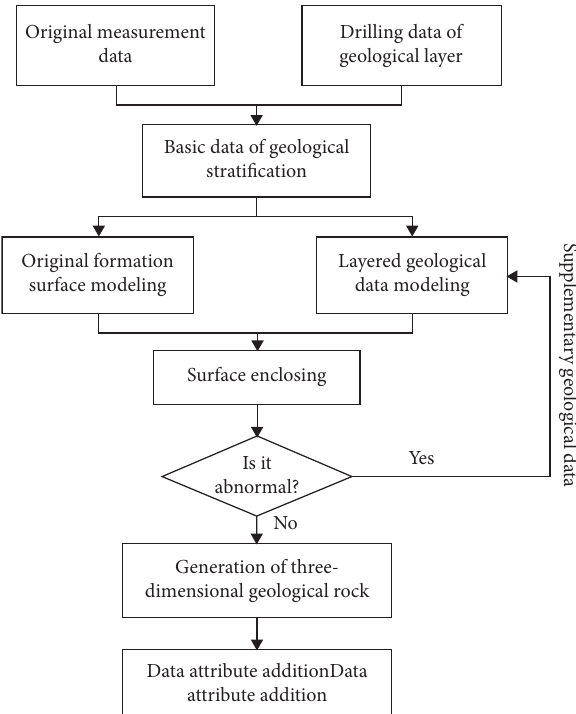
Figure 3: Modeling technology